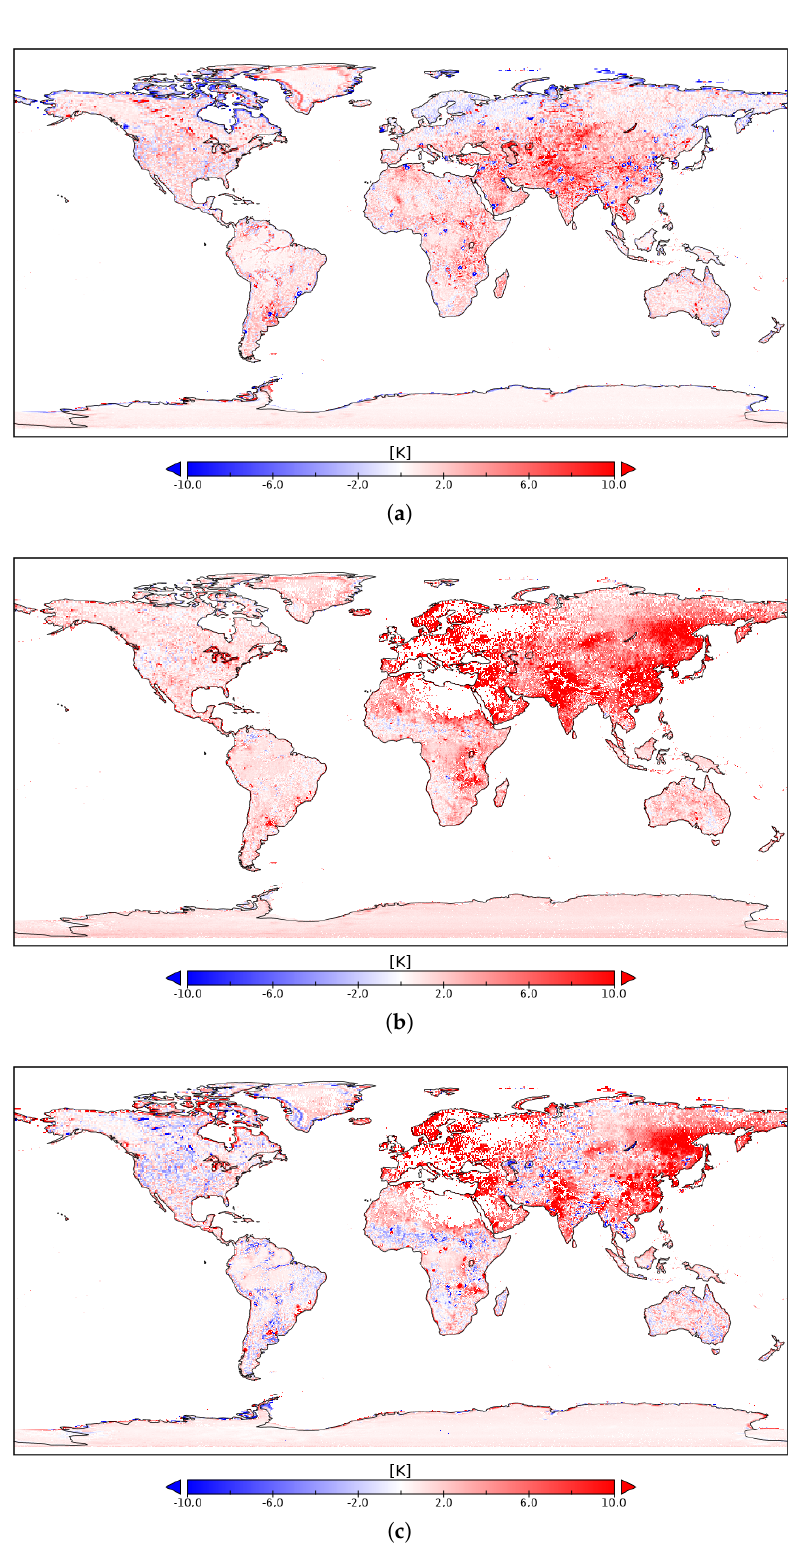
Figure 12. Maps of the difference between the error standard deviation of TB ( a ) SMOS nominal-SMOS NS (mean difference: 1.03 K), ( b ) SMOS nominal-SMAP (mean difference: 3.41 K), and ( c ) SMOS NS-SMAP (mean difference: 2.28